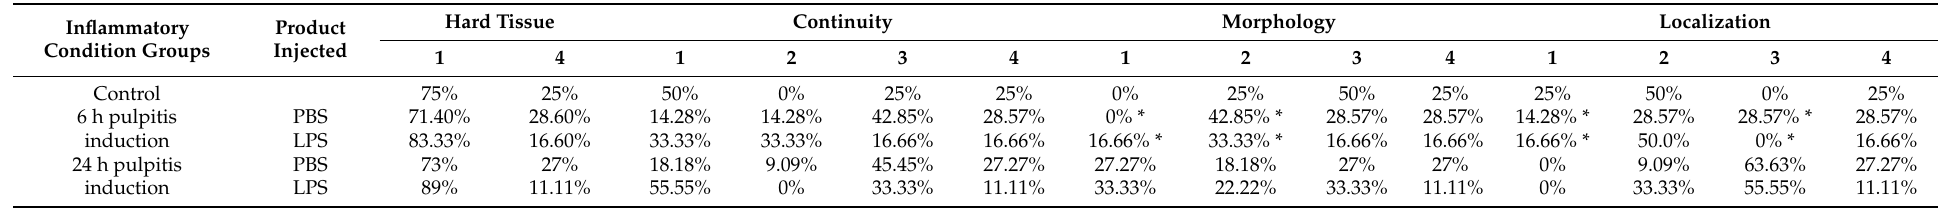
Table 4. Characterization of the mineralization reaction on Masson’s trichrome stained histological sections using the scoring table (Table 3). A t -test was performed to detect the significant differences between the groups using GraphPad Prism version 6 (GraphPad Software, CA, USA) * p < 0.05. Results for 6-h PBS and LPS treatment were significantly different from those for 24-h PBS and LPS treatment for criteria 1 and 2 of the morphology description and criteria 1 and 3 for localization